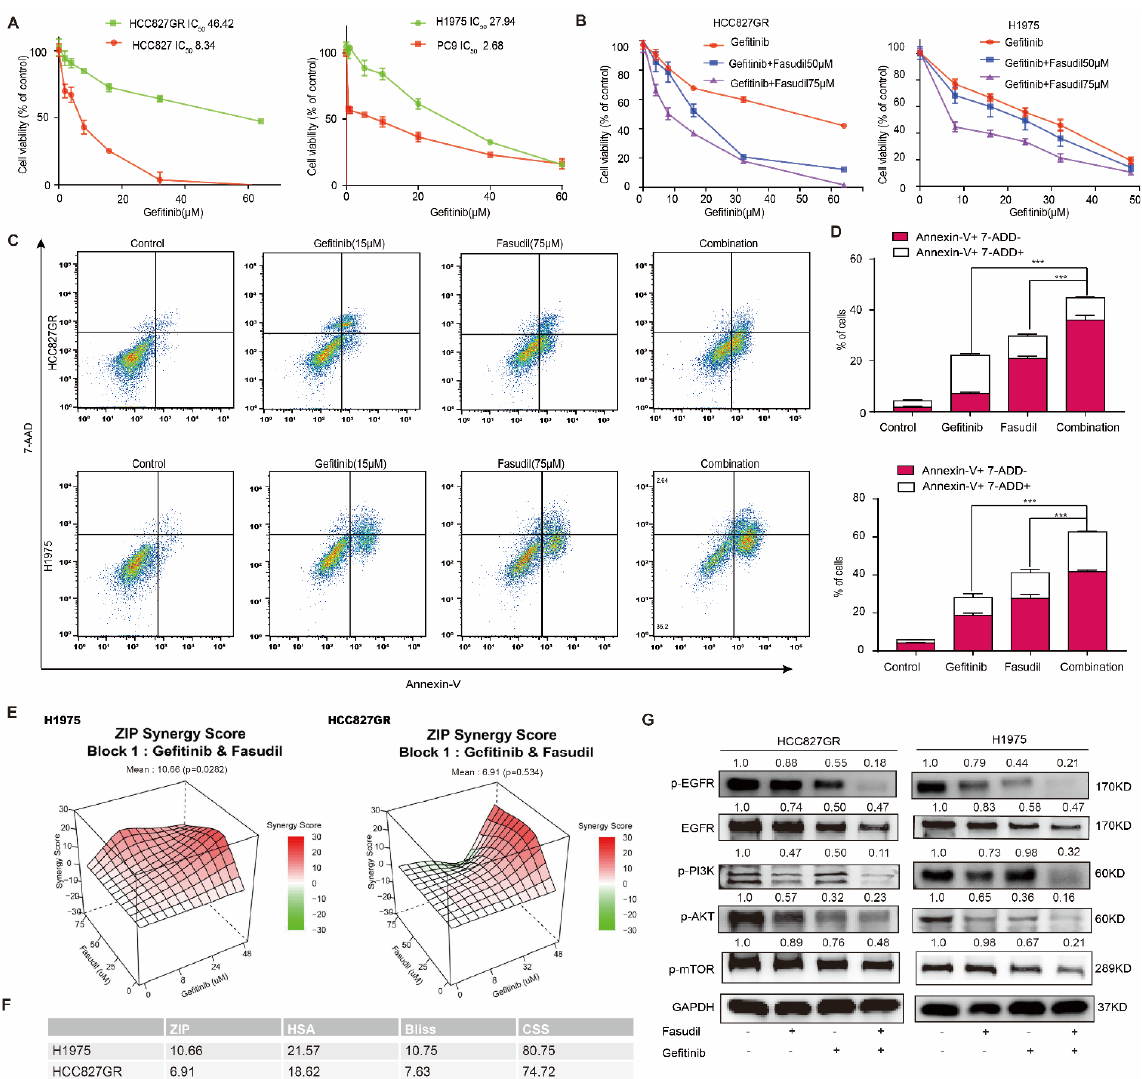
Figure 2. Effects of the combination of gefitinib with Fasudil on the growth inhibition and apoptosis in gefitinib ‐ resistant NSCLC cells. ( A ) HCC827, HCC827GR, PC9, and H1975 cells were treated with various concentrations of gefitinib for 48 h, and the CCK ‐ 8 assay was used to determine cytotoxicity. All values are expressed as the mean ± SD ( n = 4). ( B ) Combined treatment of Fasudil and gefitinib enhances the synergistic cytotoxic effects in gefitinib ‐ resistant NSCLC cells. Gefitinib monotherapy (0, 8, 16, 24, 32, 48 μ mol/L) or treatment with gefitinib in combination with Fasudil (50 or 75 μ mol/L) for 48 h. ( C ) HCC827GR and H1975 cells subjected to Fasudil and gefitinib monotherapy or Fasudil and gefitinib combination therapy for 48 h. The percentage of apoptotic cells was determined via flow cytometry. ( D ) Quantification of the apoptotic cells, data are presented as mean ± SD based on triplicate measurements. *** p < 0.001 were considered statistically significant. ( E ) The 3D plot of ZIP synergy score (left: H1975, right: HCC827GR). The mean ZIP scores of H1975 and HCC827GR were 10.66 and 6.91, respectively, which meant the interaction was likely to be synergistic. ( F ) The ZIP score, HSA score, Bliss score, and CSS score of H1975 and HCC827GR cells. ( G ) Western blotting of p ‐ EGFR, EGFR, p ‐ AKT, and p ‐ PI3K. GAPDH was included as a loading control. Protein expression was quantified by ImageJ software. The uncropped blots are shown in Supplementary File S1.